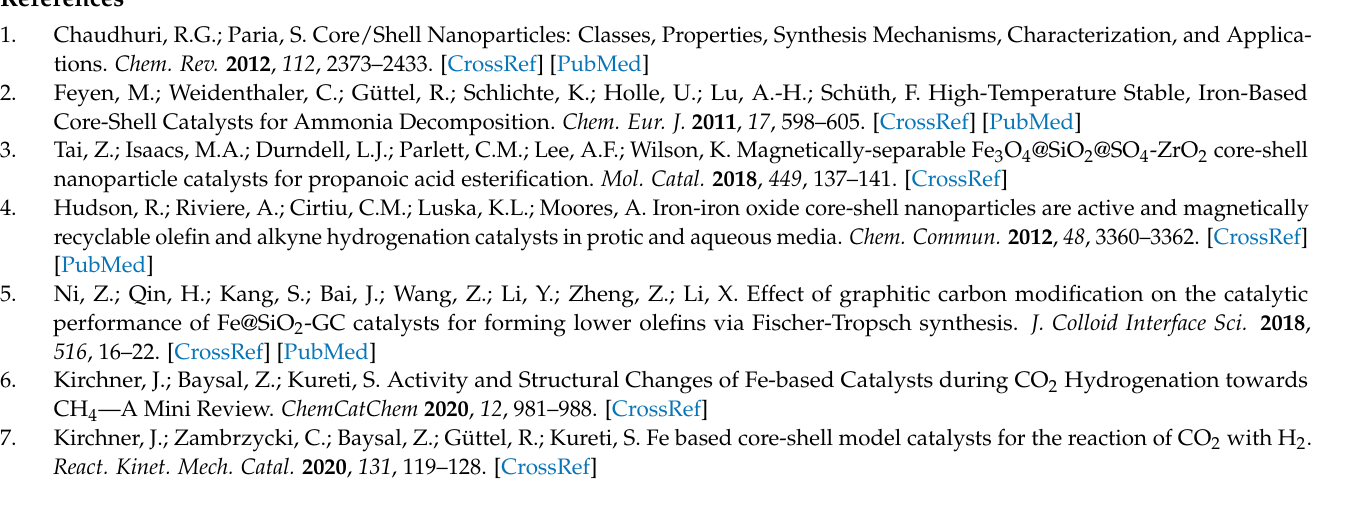
6 nm. Figure S3: TEM micrographs of as-made core-shell particles with an average core diameter of 8 nm. Figure S4: Time resolved product formation rates during CO 2 hydrogenation. Figure